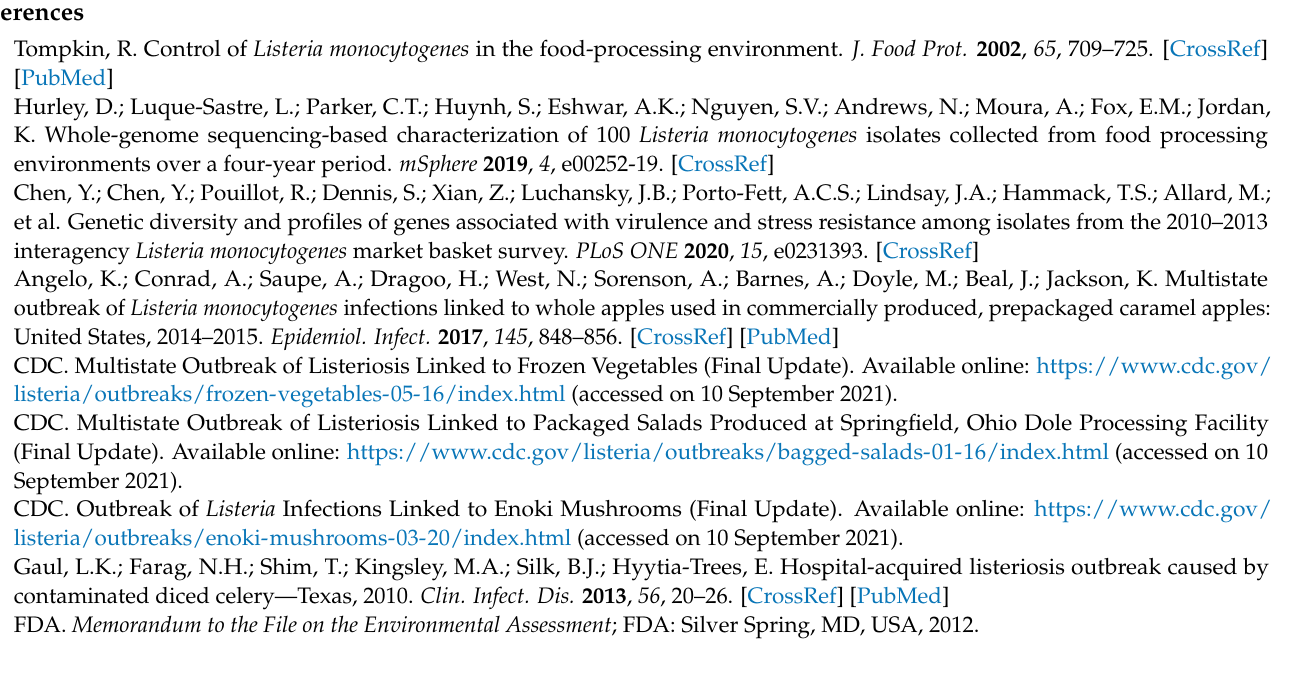
Table S2: NCBI Accession numbers used to screen for antimicrobials tolerance determinants and virulence genes, Table S3: GoTerm analysis of select CC155 accessory genes annotated as DNA binding, transcriptional regulator or membrane component, Figure S1: Pairwise SNP